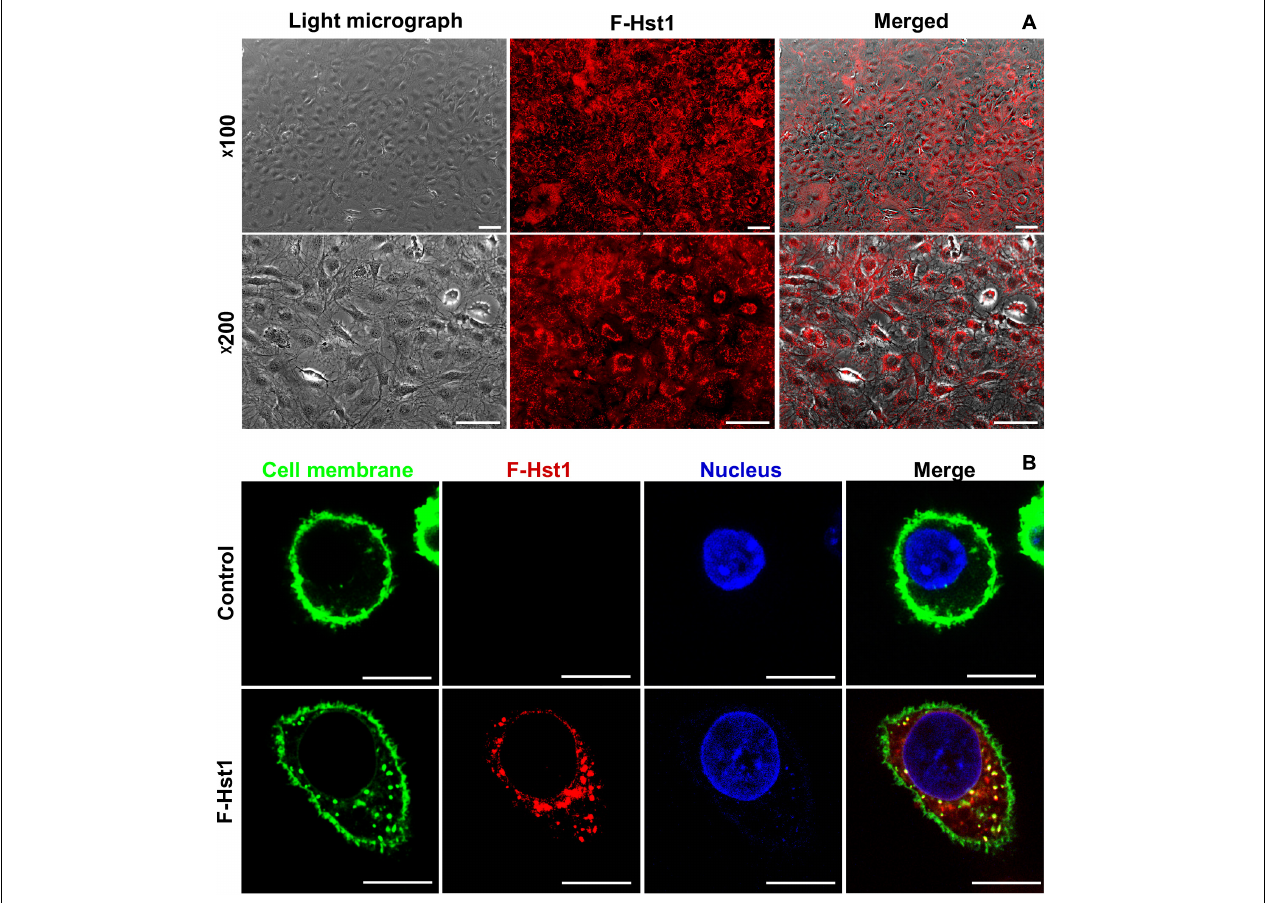
FIGURE 3 | The uptake and distribution of F-Hst1 in osteogenic cells. (A) Light (left column) and fluorescent (middle column) micrographs depicting the uptake of fluorescently labeled Hst1 (F-Hst1) (middle column) by osteogenic cells (left column) in lower (upper row) and higher (lower row) magnification. Bar = 100 µ m. (B) Cellular uptake of the fluorescence (ATTO-647N)-labeled Hst1 (F-Hst1). CLSM images of F-Hst1 variants (in red) were taken up by osteogenic cells; cell membrane are stained in green; nuclei are stained in blue; Bar = 20 µ